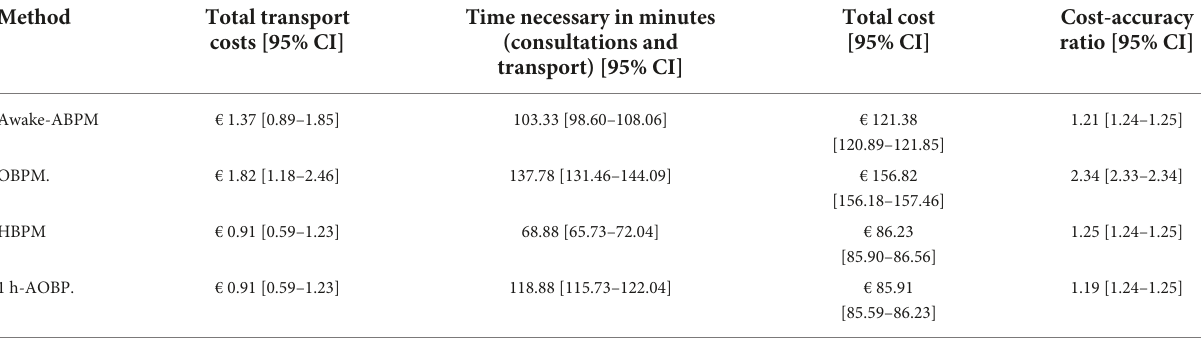
TABLE 2 Cost and time study of diagnosing